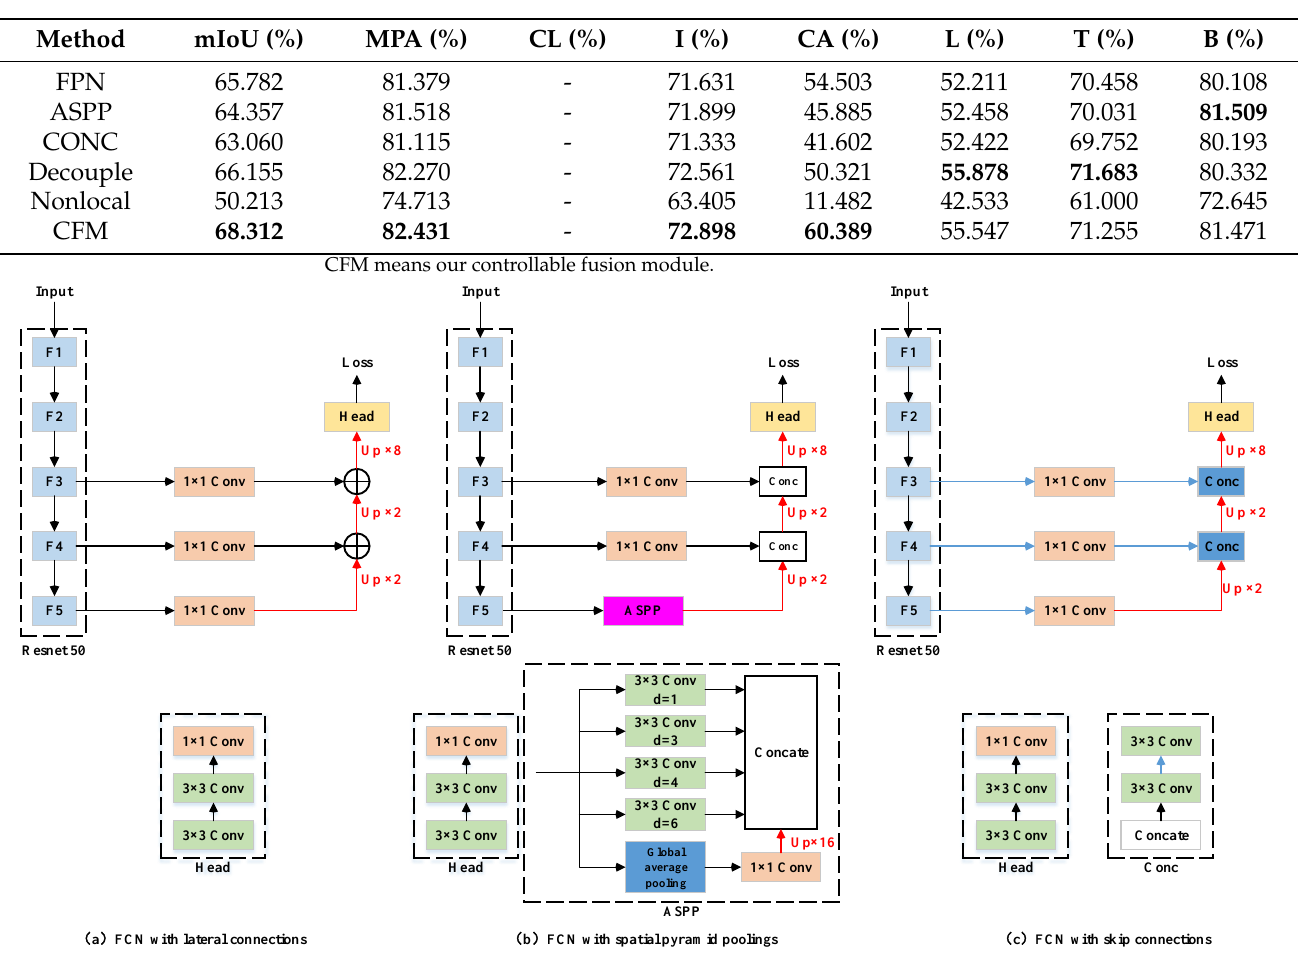
Table 6. Results of different fusion modules on Vaihingen dataset. CL means clutter. I means impervious surface. CA means car. L means low vegetation. T means tree. B means building. The highest scores are marked in bold.